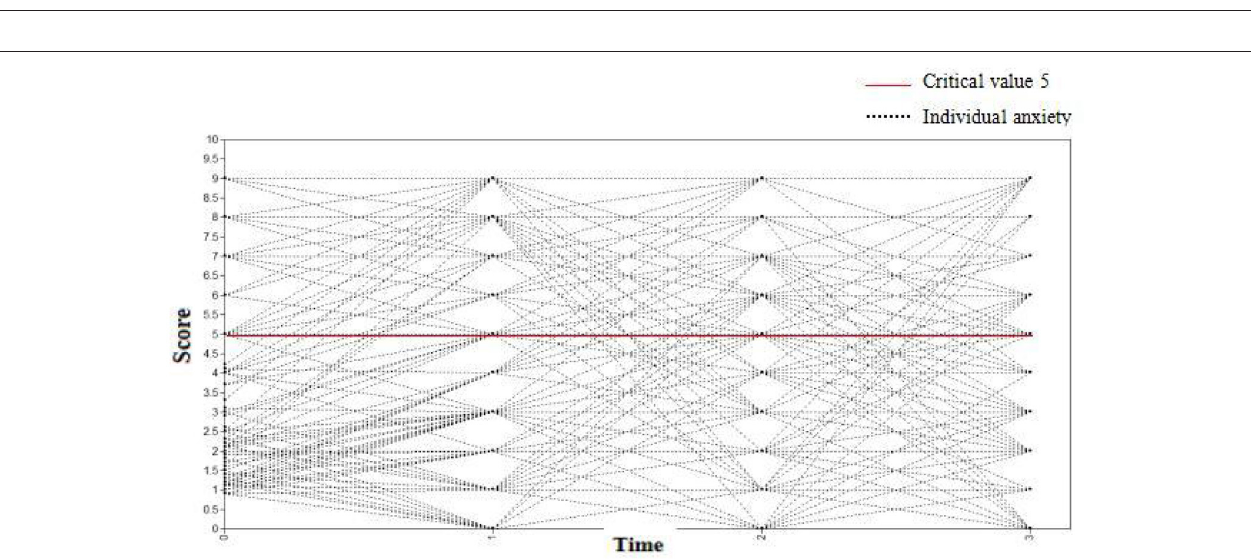
FIGURE 5 | The changing trajectory of anxiety of medical staff at four observation time.